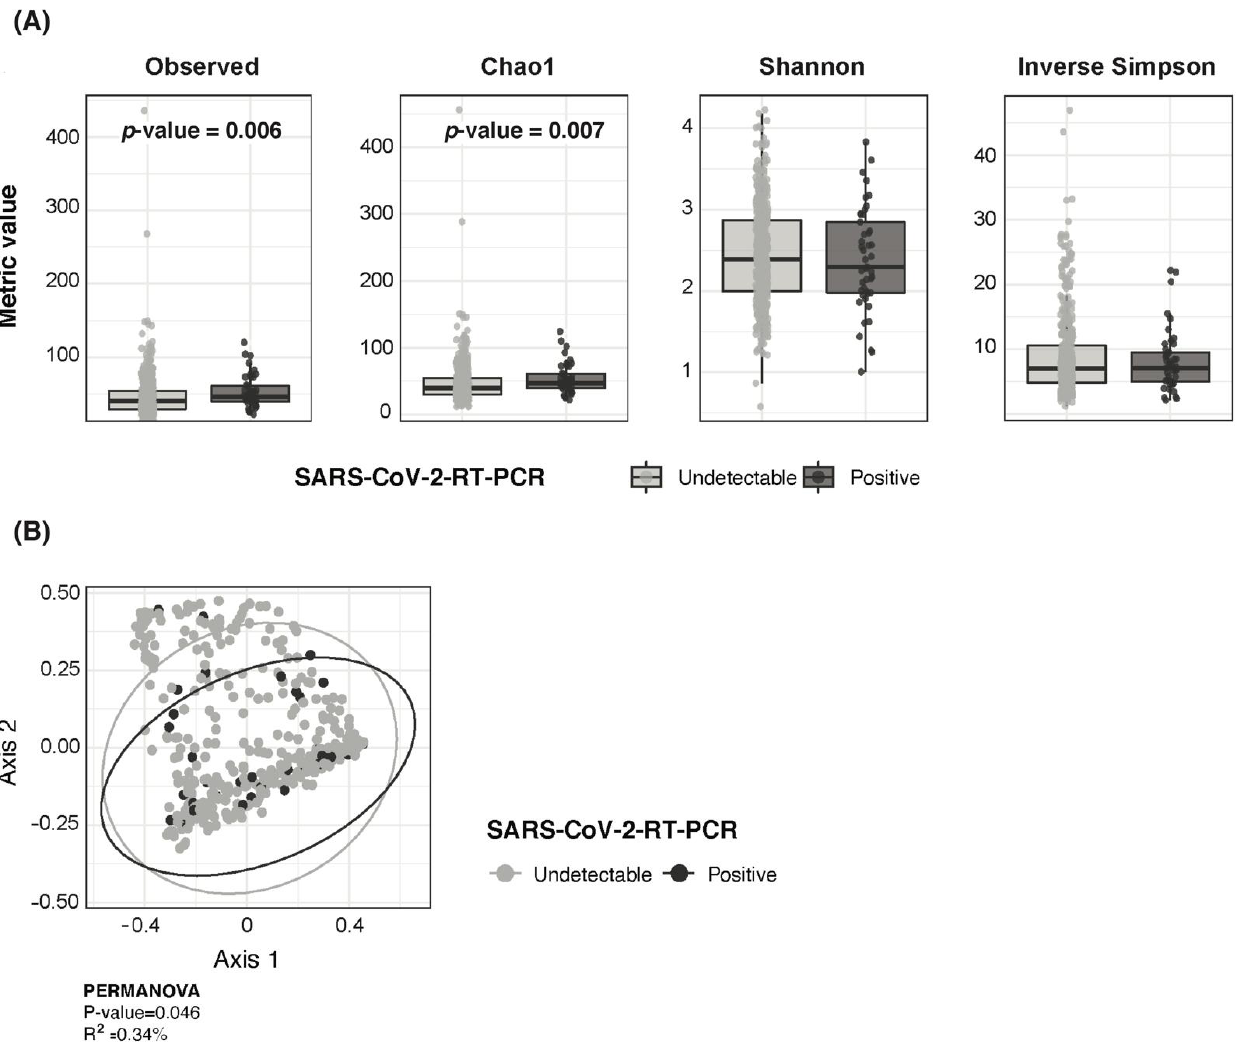
Figure 2. Pediatric SARS-CoV-2 infection associated with higher bacterial richness but similar di- versity and overall microbiota composition. ( A ) Boxplots showing richness (Observed and Chao 1) diversity (Shannon and Inverse Simpson) metrics between SARS-CoV-2 RNA detection groups in chil- dren. ( B ) PCoA ordination analysis on Bray–Curtis ecological distance matrix showing distribution of SARS-CoV-2 positive and negative pediatric